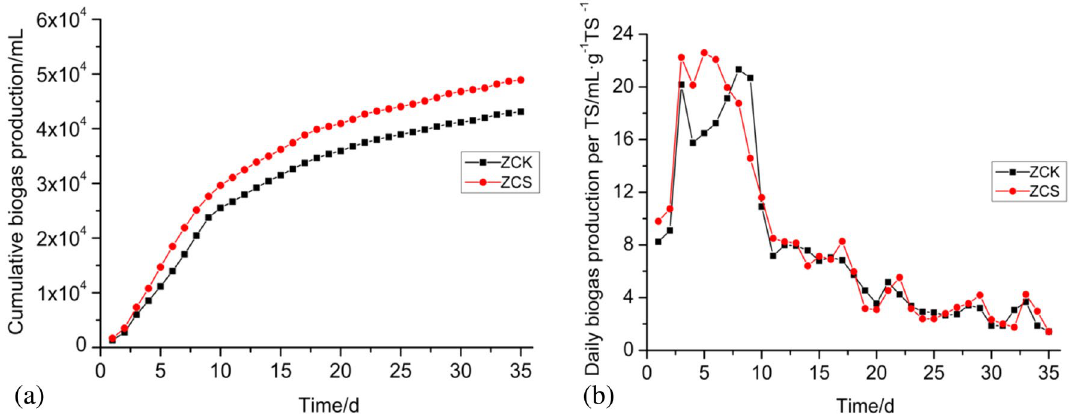
Figure 1. ( a ) Cumulative biogas production; ( b ) Change of biogas production per